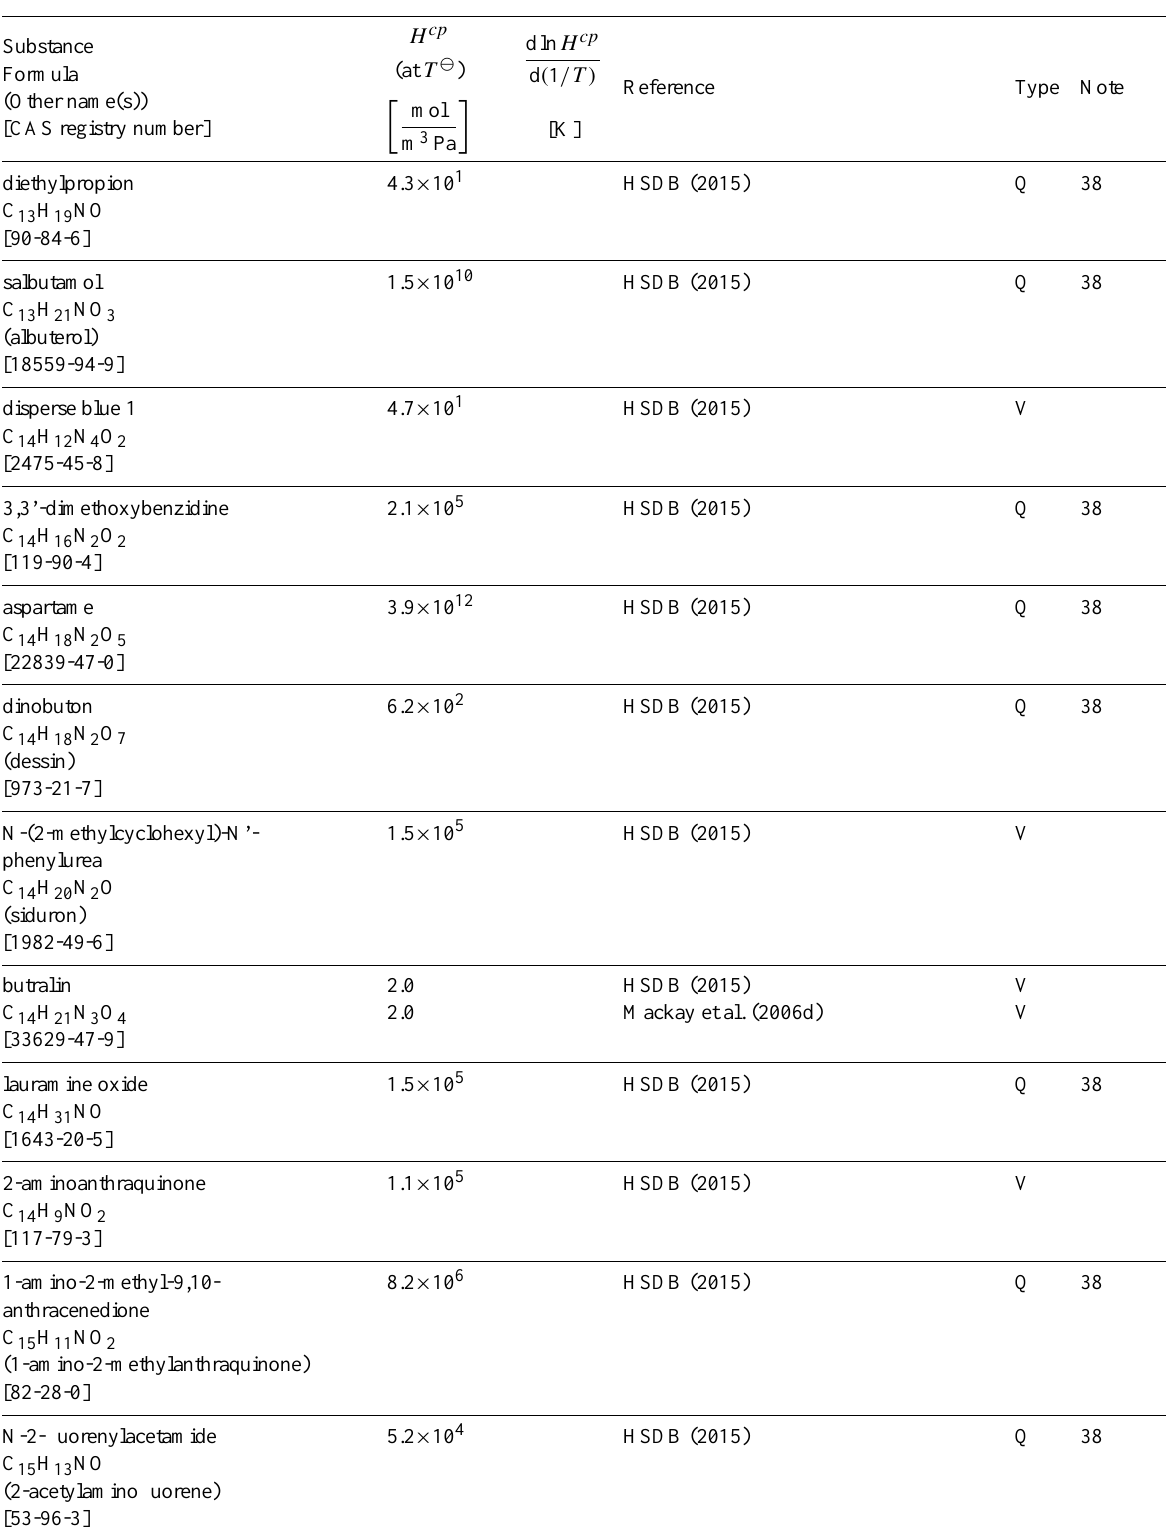
Table 6: Henry’s law constants for water as solvent